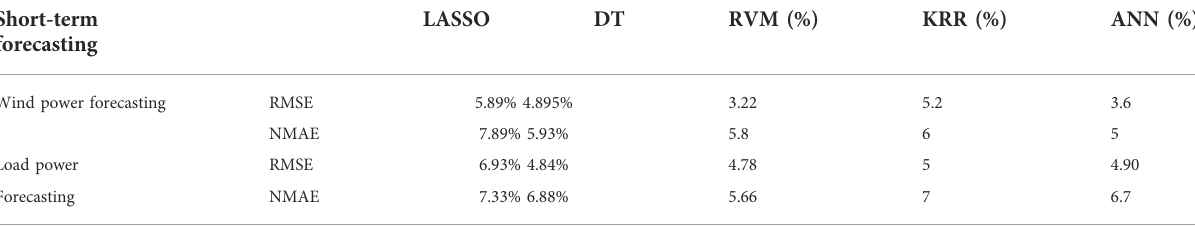
TABLE 5 Performance comparison of short-term wind power production and load demand prediction using different ML techniques. Short-term forecasting